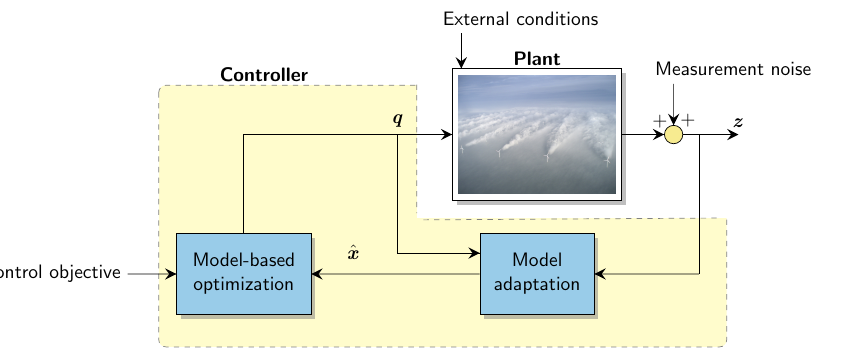
Figure 1. Closed-loop wind farm control framework. Measurements z (e.g., SCADA or lidar data) are fed into the controller. First, the state of the surrogate model x is estimated to represent the actual atmospheric and turbine conditions inside the wind farm. Secondly, using the calibrated model, an optimization algorithm determines the control policy (e.g., yaw angles) for all turbines q . This control policy may be a set of constant operating points, but can also be time-varying, depending on whether the surrogate model is time-varying and the employed optimization algorithm. The photograph of the wind farm is from Christian